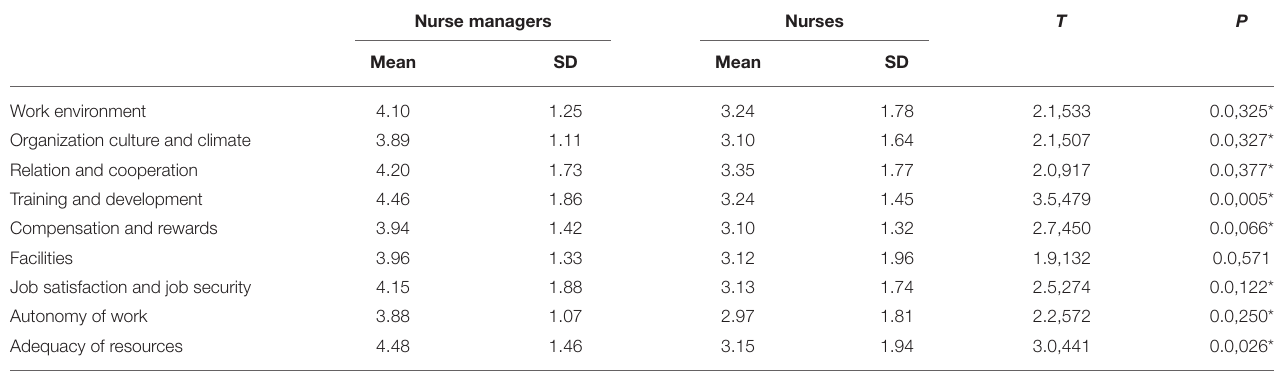
TABLE 2 | Nurse managers’ and staff nurses’ perceptions of quality of work life.